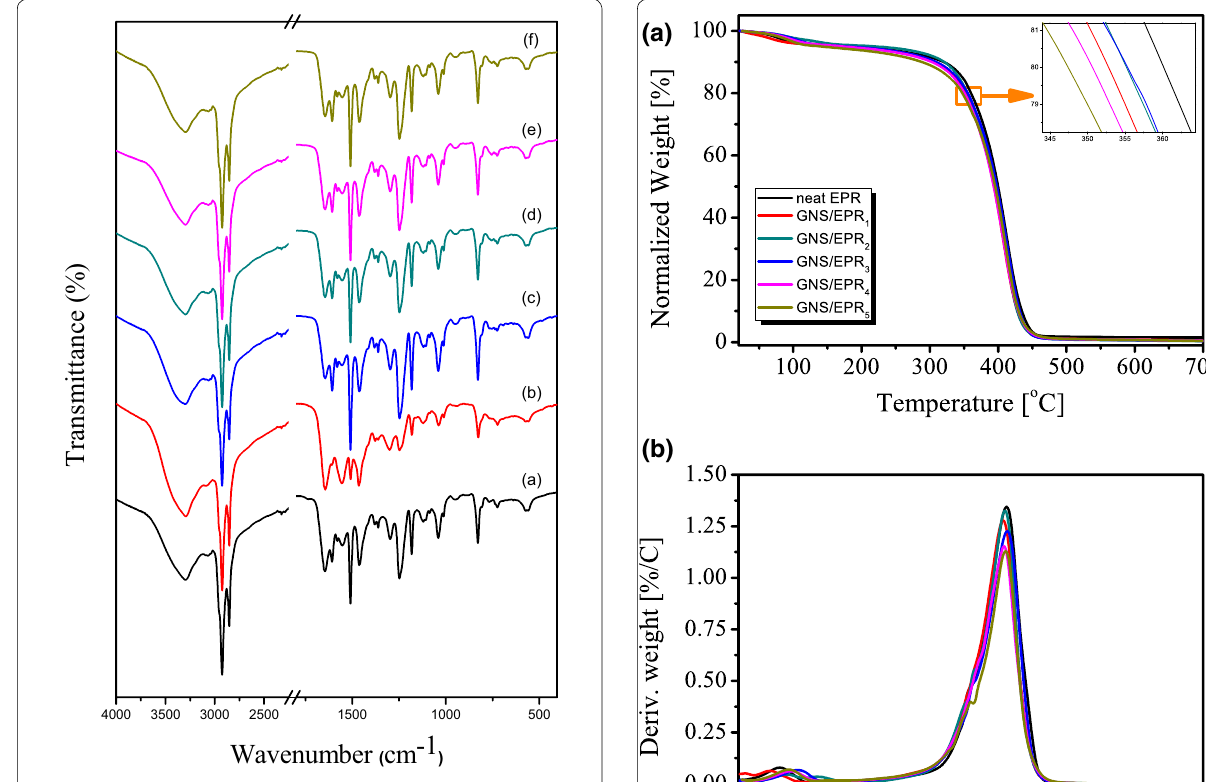
Fig. 3 FT‑IR spectra of neat EPR ( a ), GNS/EPR 1 ( b ), GNS/EPR 2 ( c ), GNS/ EPR 3 ( d ), GNS/EPR 4 ( e ) and GNS/EPR 5 ( f )